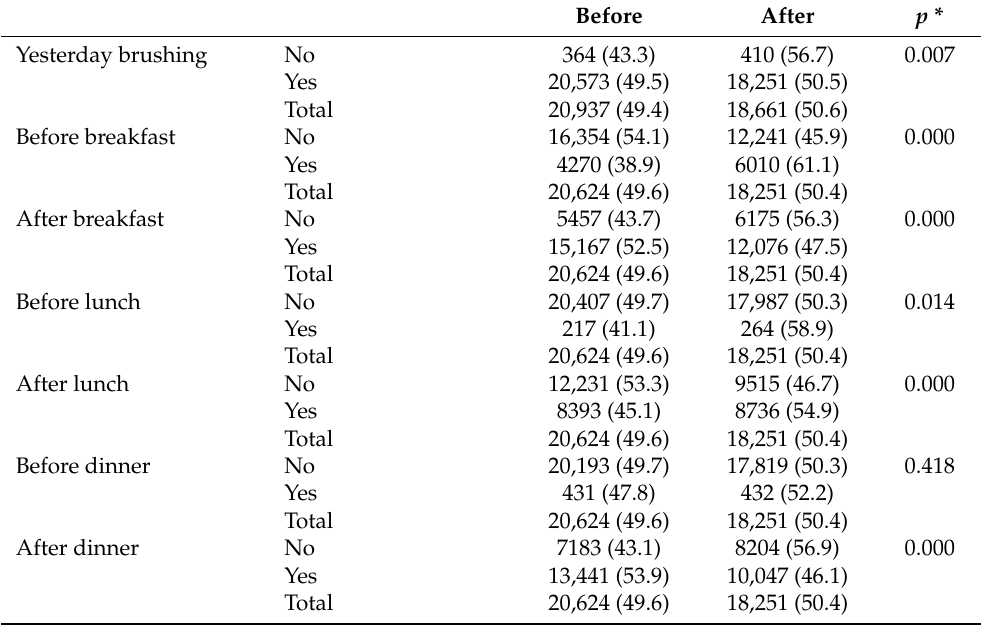
Table 4. Comparison of the subjects’ brushing (Unit: